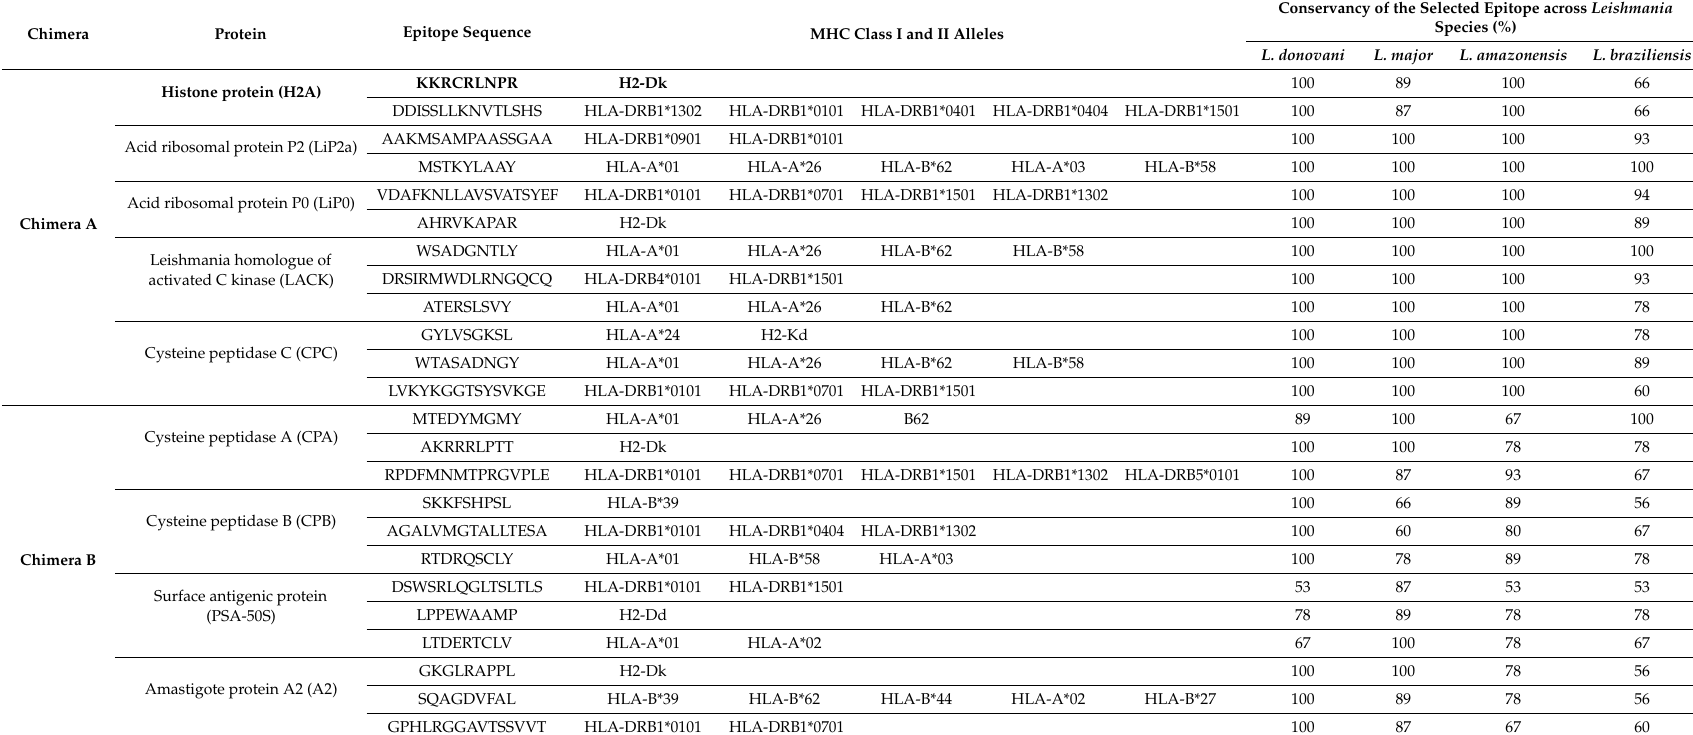
Table 1. MHC class I and II epitopes of known Leishmania infantum proteins that have been shown as candidate vaccines for leishmaniasis. The amino acid sequence, alleles, and conservancy of these promiscuous epitopes are represented in the table. The epitopes were selected through an immunoinformatics pipeline describe by [9,11] and they showed a high score for the algorithms NetMHC, NetCTL, and NetMHCII.